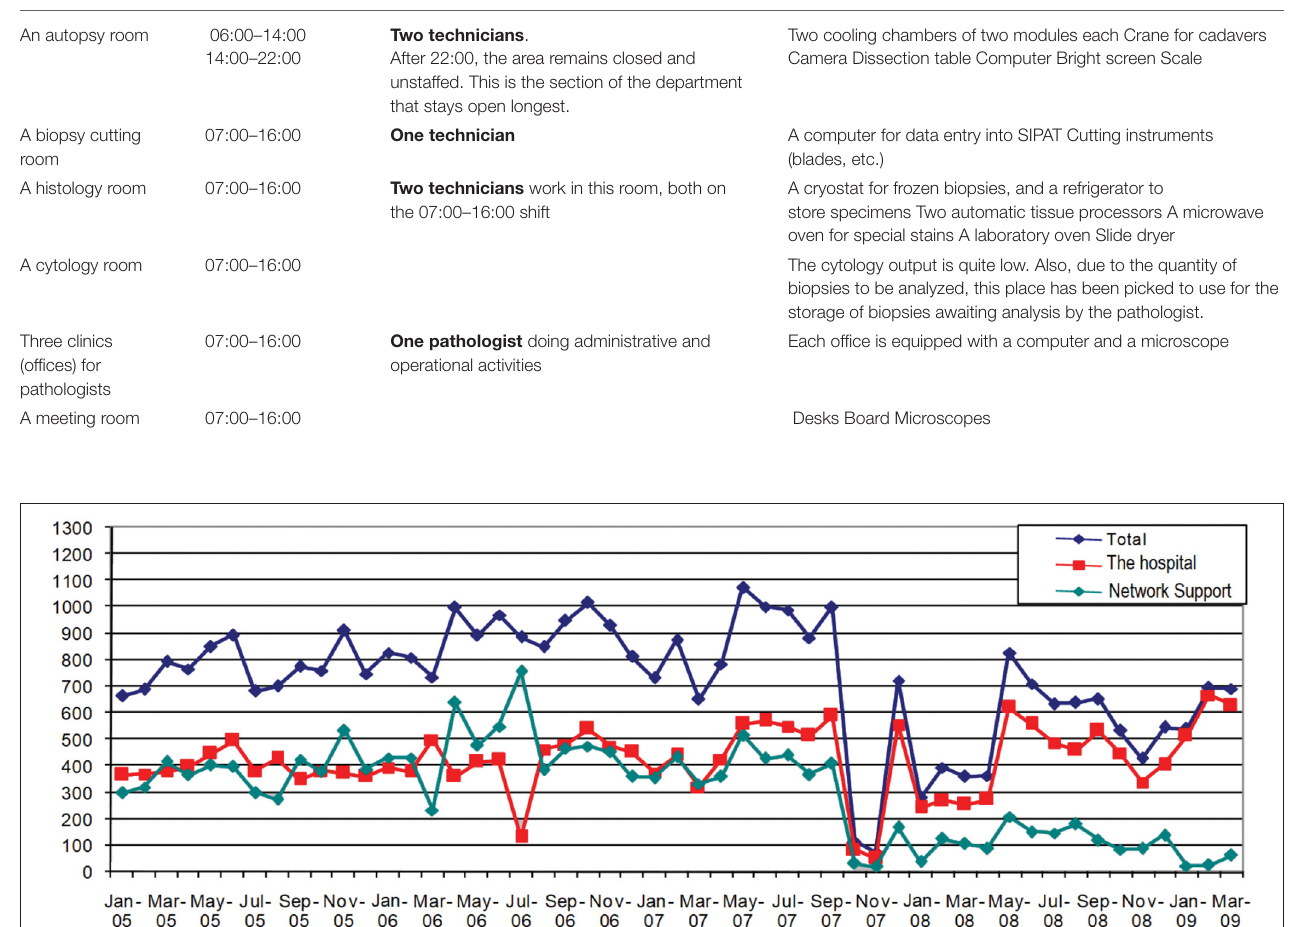
TABLE 1 | Resources available in the anatomic pathology department. Area